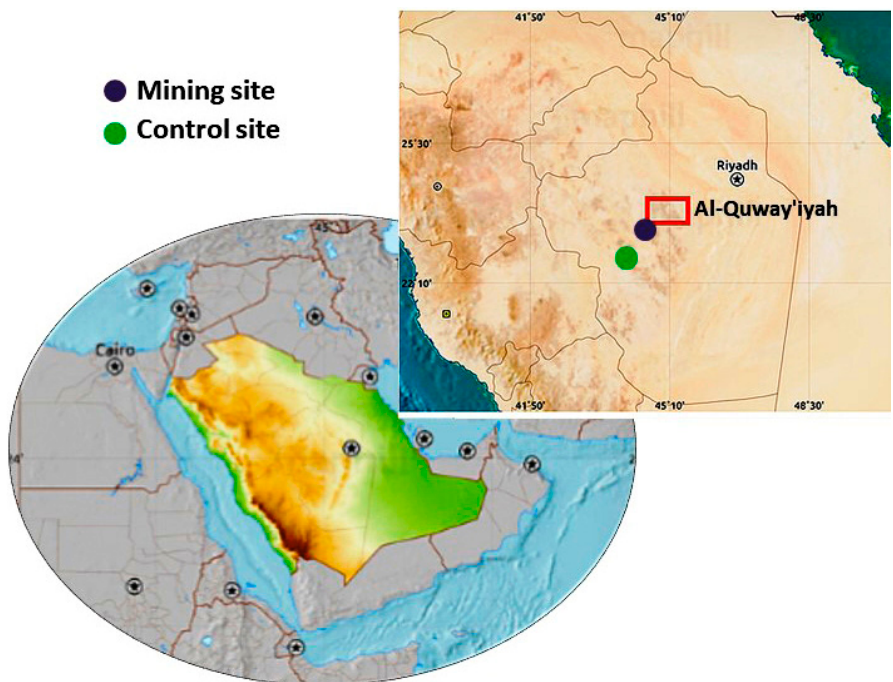
Figure 1. Location map of the mining and control sites.